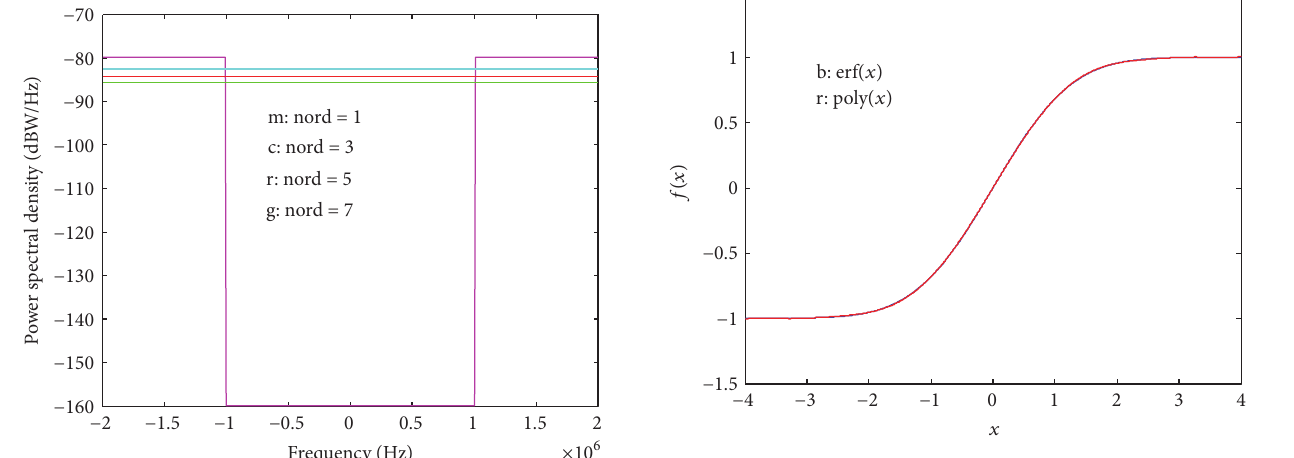
Figure 4: Soft limiter input-output